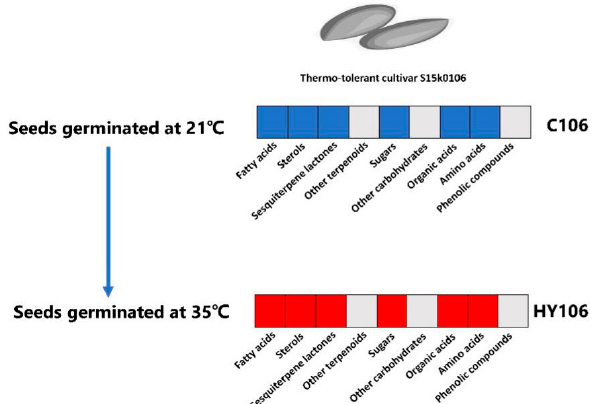
Figure 4. Di ff erential metabolites detected between the thermotolerant lettuce seeds germinated at 21 ◦ C and 35 ◦ C. Note: The heatmap indicates the di ff erential metabolites detected between buds of S15k0106 seeds germinated at 21 ◦ C (C106) and 35 ◦ C(HY106). A red box means that most of the metabolites in this class had higher relative abundances in HY106 compared to those in C106, while a blue box represents that relative abundances of most of the metabolites in this class were lower in C106 than those in HY106; a gray box denotes no significance between C106 and HY106.